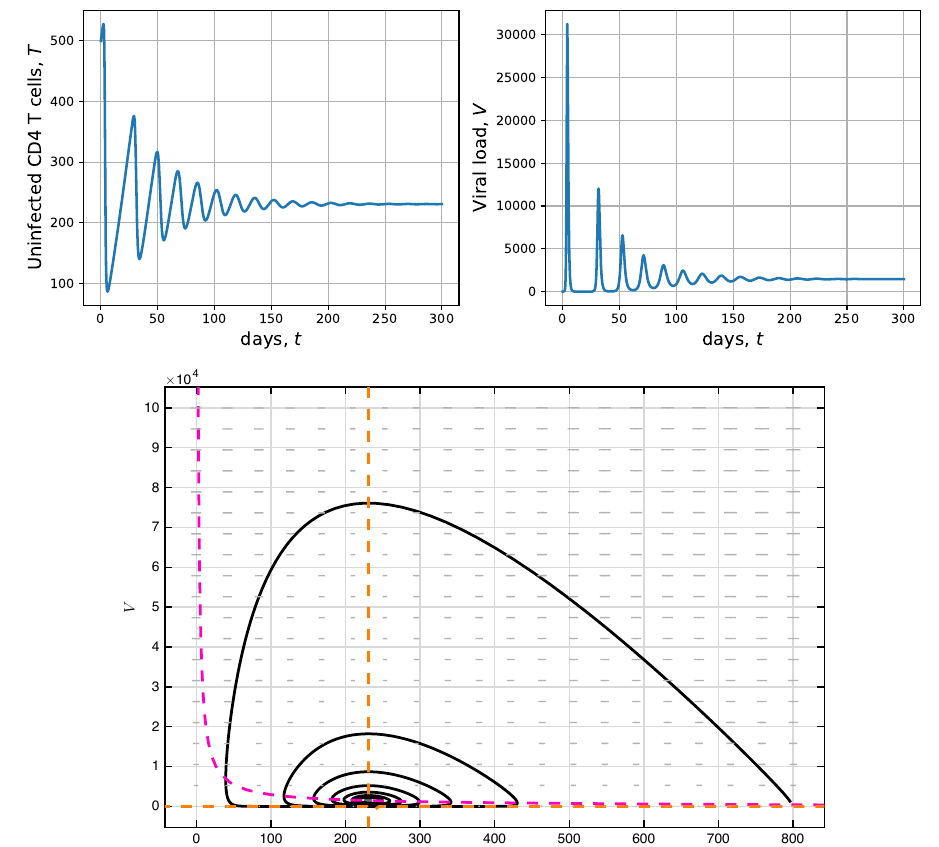
Figure 2. Numeric solutions vs. time ( top panels ) and phase space ( bottom panel ), corresponding to uninfected CD4 T-cells and viral load in model (1), with β = 4 × 10 − 5 and R 0 = 5.0175 are shown. In this scenario, the endemic equilibrium E 1 is locally asymptotically